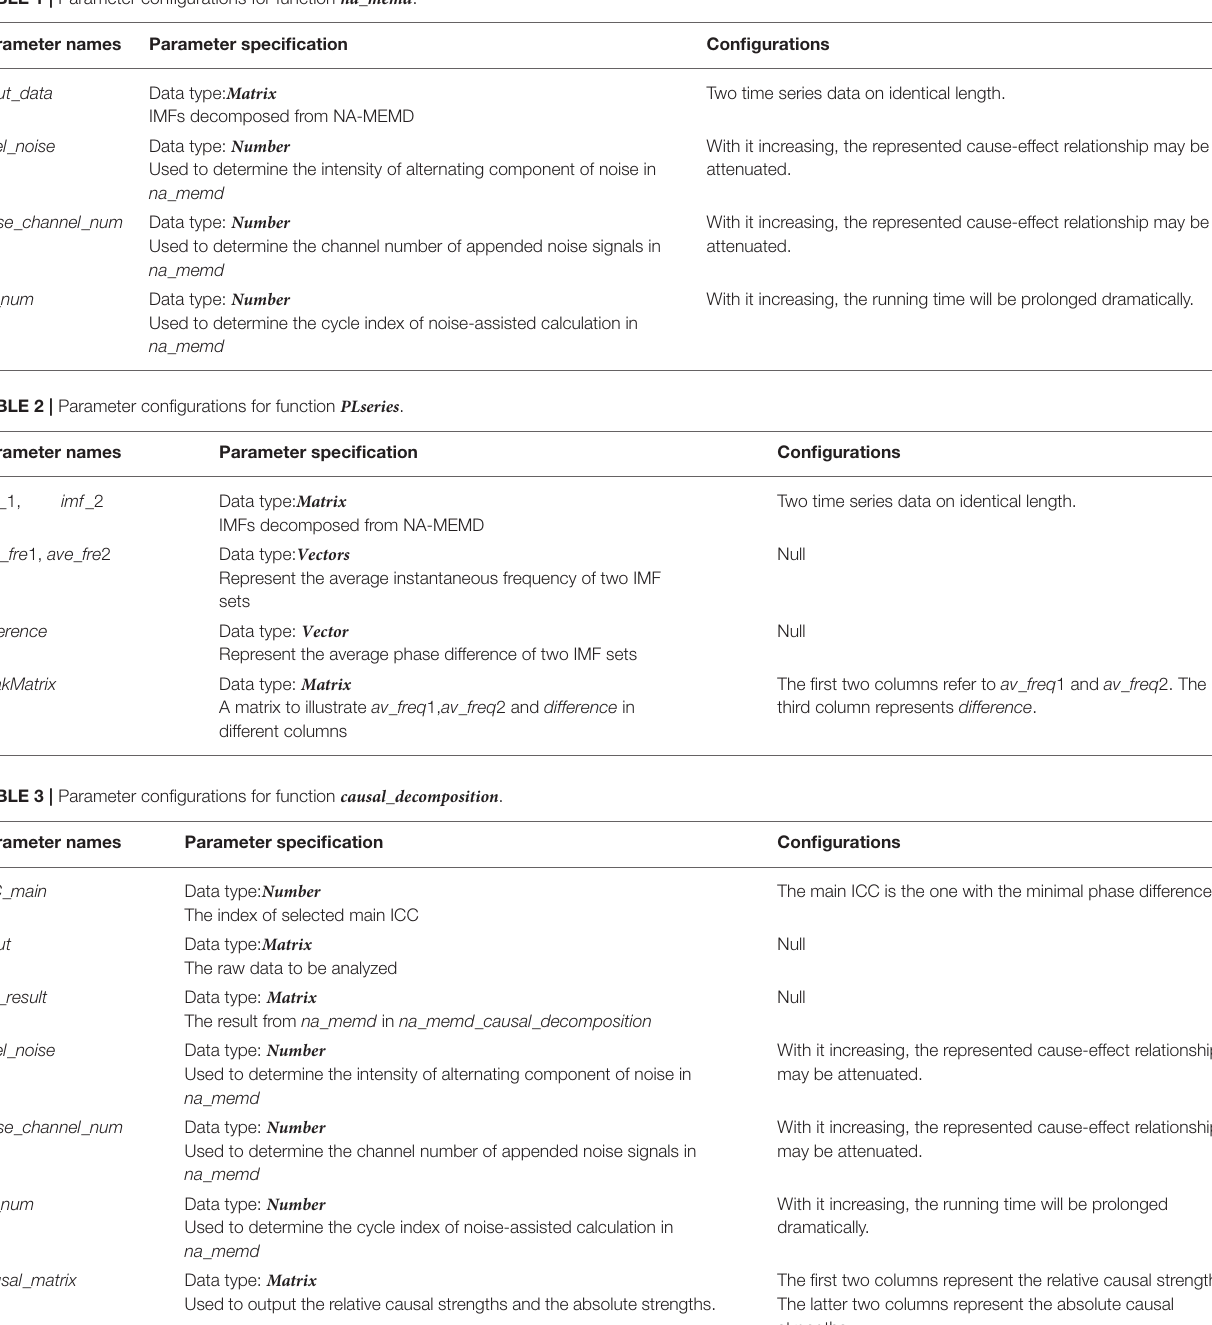
TABLE 1 | Parameter configurations for function na _ memd .